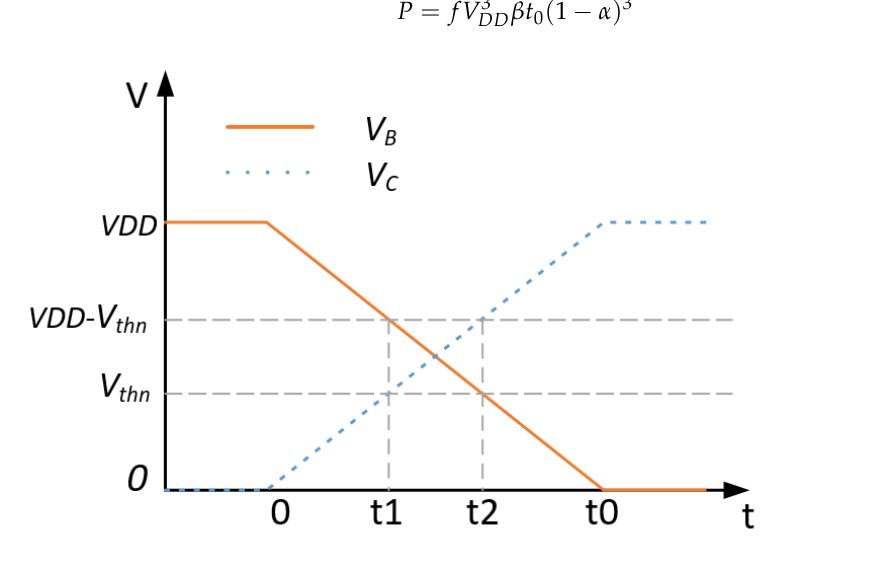
Figure 3. Timing diagram of the traditional CP.